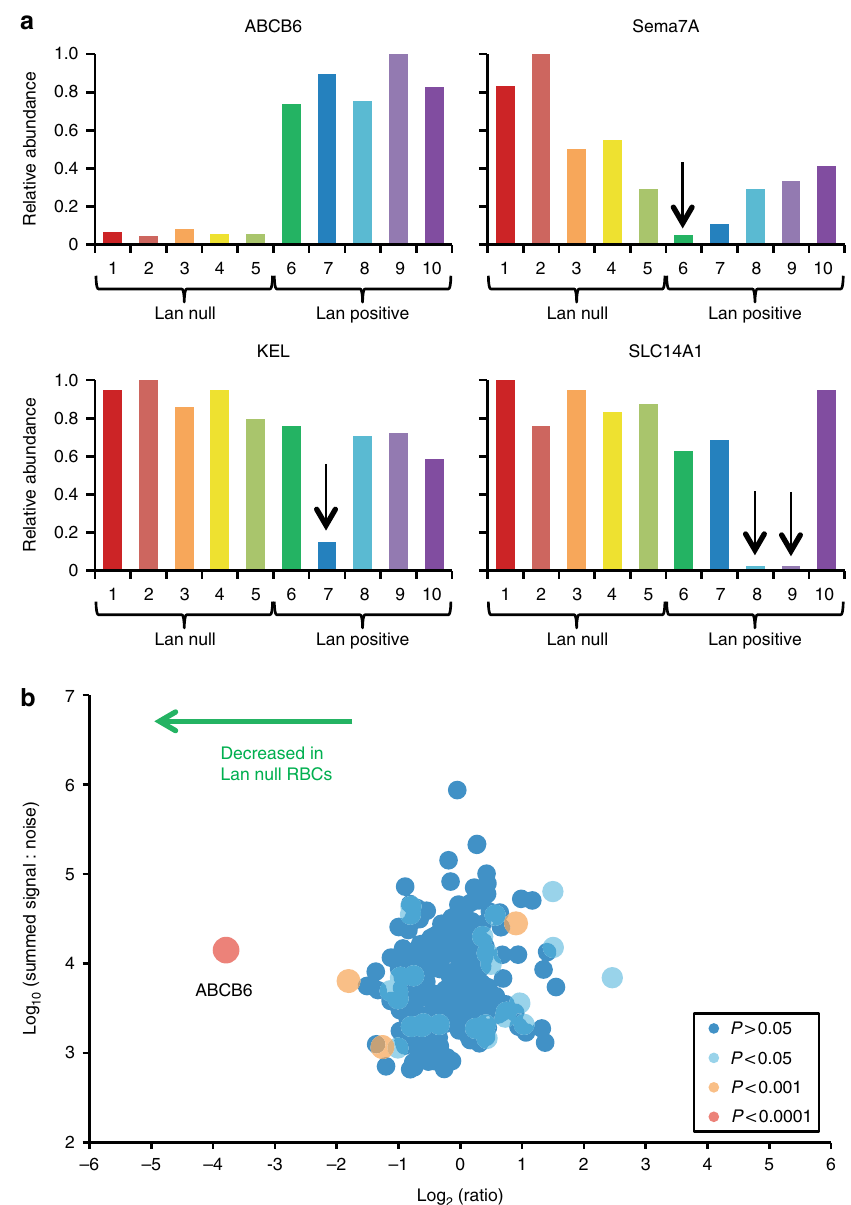
Fig. 5 Plasma membrane pro fi ling of Lan null and control erythrocytes reveals speci fi c absence of ABCB6. a Quanti fi cation of ABCB6, Sema7A, KEL, and SLC14A1 proteins (which encode the Lan, JMH, Kell, and Kidd blood group antigens, respectively) in erythrocyte samples from 10 donors by tandem mass tag-based proteomic plasma membrane pro fi ling. Donors 1 – 5 were known to be Lan null, and donors 6 – 10 known Lan-positive controls. Donor 6 was also known to be JMH null, donor 7 Kell null, and donors 8 and 9 were Kidd null. b Scatter plot of all 265 proteins quanti fi ed by two or more peptides and annotated ‘ plasma membrane ’ by Gene Ontology. The x -axis shows average fold change, calculated for each protein by sum (signal:noise) Lan null samples/sum (signal:noise) control samples. P -values were estimated using a two-tailed t -test, corrected for multiple hypothesis testing using the method of Benjamini –